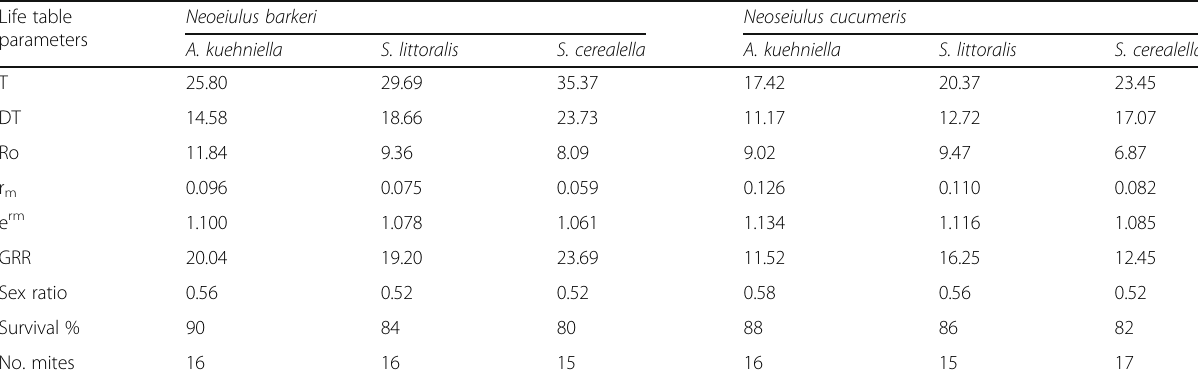
Table 6 Life table parameters of Neosiulus cucumeris and N. barkeri fed on three different kinds of insect eggs and incubated at 27 ° C and 70% RH Life table